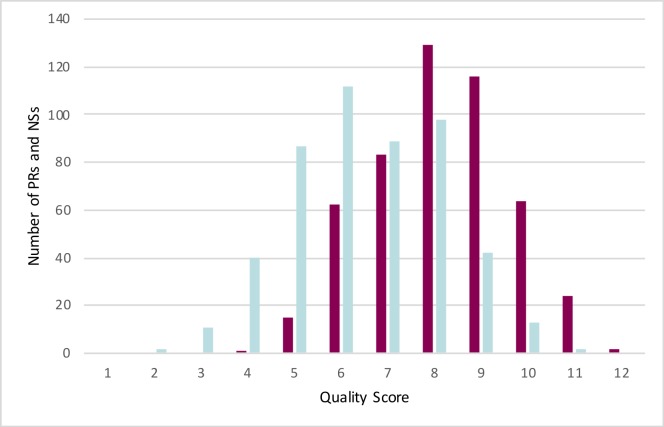
Histogram for the aggregated number of quality measures in PRs & NSs.Purple bars: PRs, blue bars: NSs.